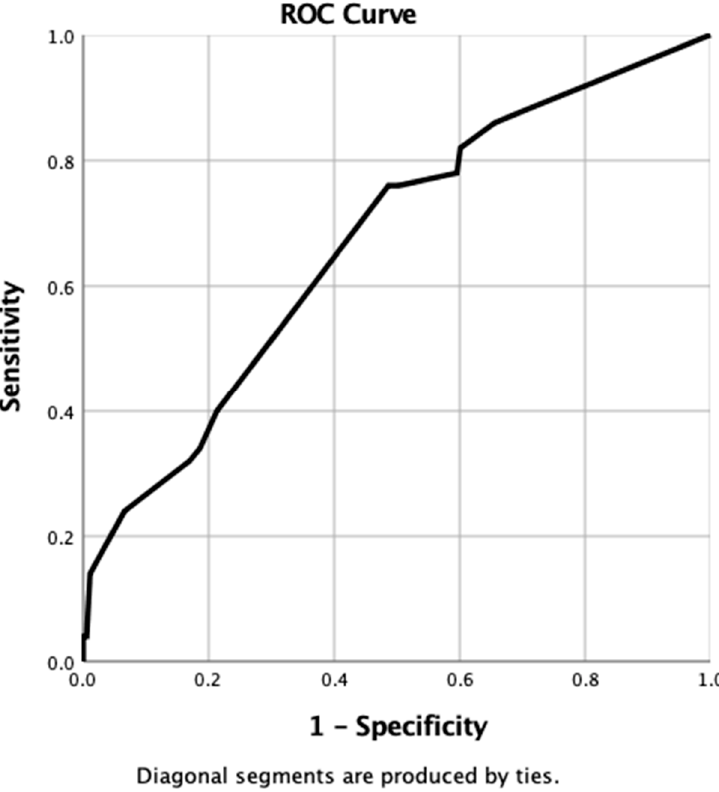
Figure 3. ROC curve generated from probabilities derived from clinical nomogram.